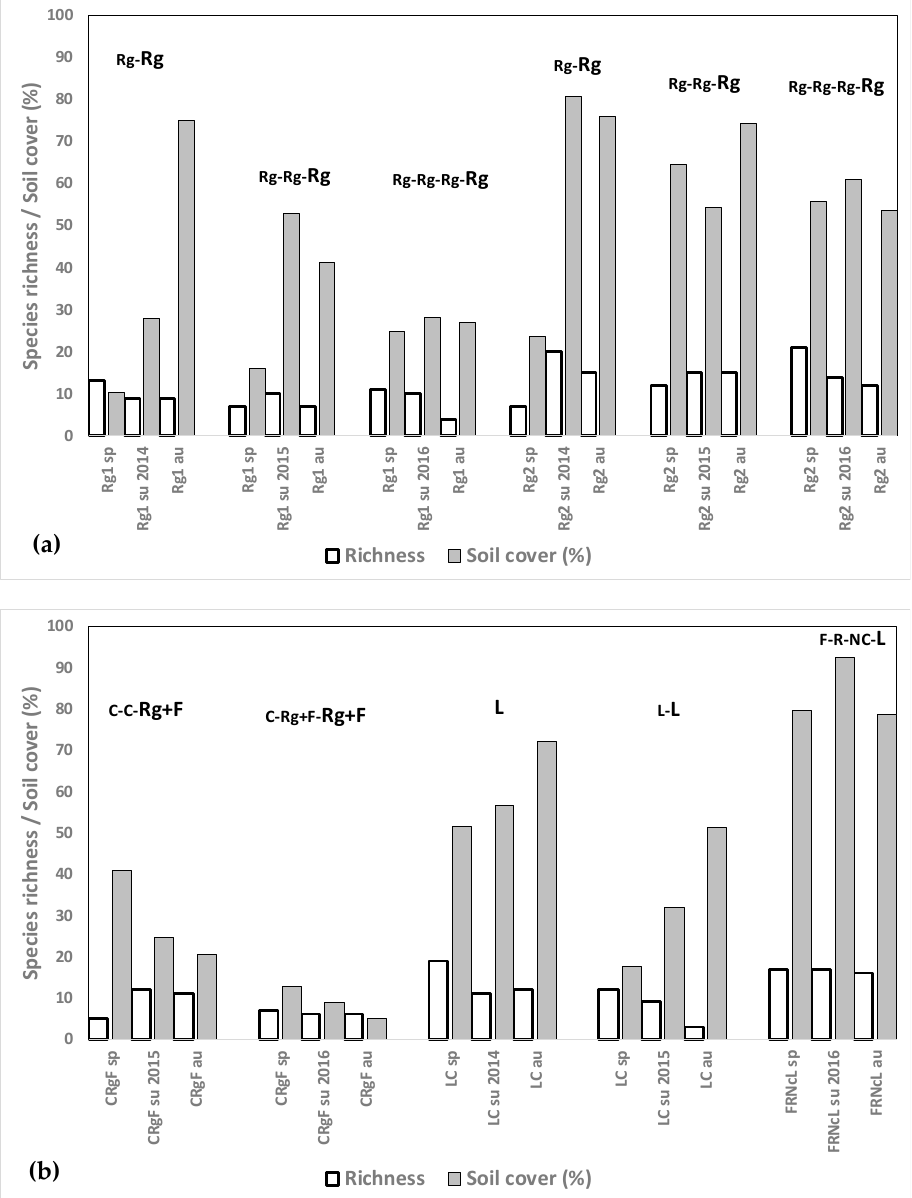
Figure 7. ( a ) Weed species richness and total weed soil cover (%) for the ryegrass fields after growing rice in spring, summer and autumn 2014, 2015 and 2016 in different crop rotation sequences. The letters show the crops from 2013 until the sampling moment, the sampled crop being the last of the rotation (in larger letters). ( b ) Weed species richness and total weed soil cover (%) for the fescue+ryegrass and lucerne fields after growing rice in spring, summer and autumn 2014, 2015 and 2016 in different crop rotation sequences. The letters show the crops from 2013 until the sampling moment, the sampled crop being the last of the rotation (in larger letters). C: cereal, R: rice, Rg: ryegrass, F: fescue, Nc: no crop, L: lucerne.